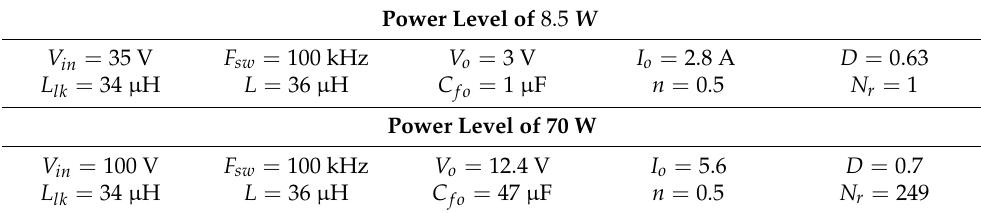
Table 4. Main parameters for each operating point.